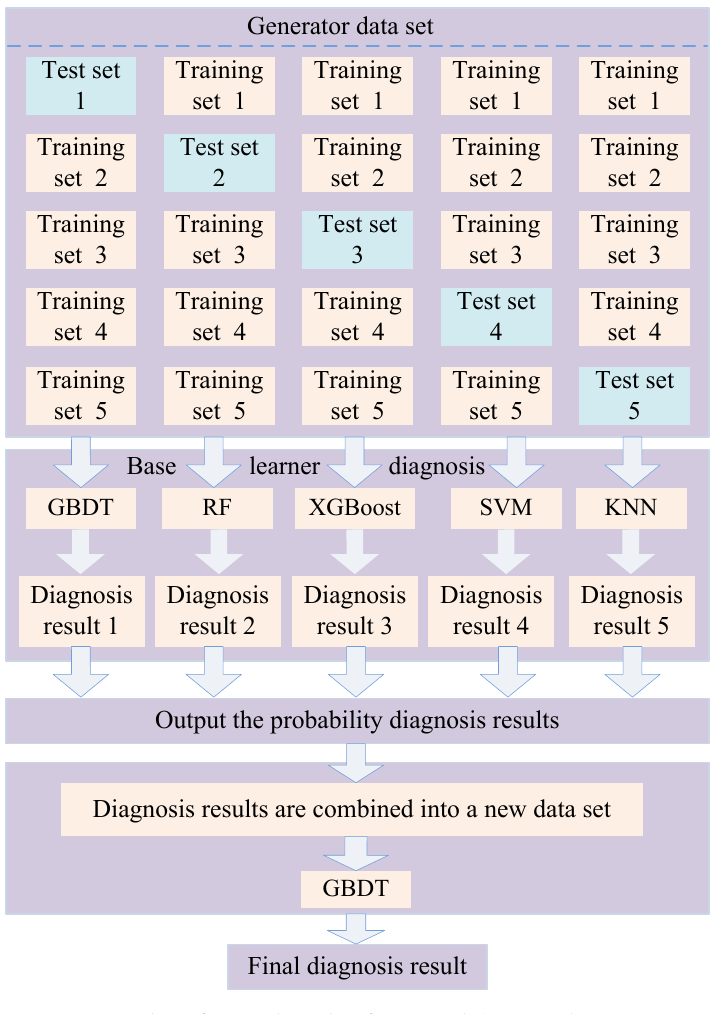
Figure 11. Stacking fusion algorithm framework (RF: Random Forest; SVM: Support Vector Machines; KNN: K Near Neighbor; GBDT: Gradient Boosting Decision